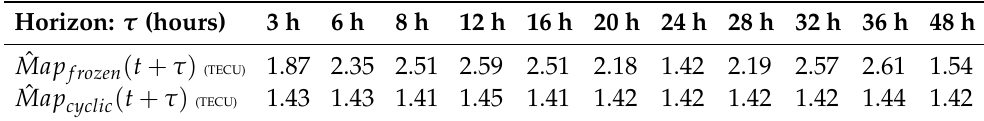
Table 4. Forecasting RMSE (TECU) for ˆ Map frozen ( t + τ ) vs. ˆ Map cyclic ( t + τ ) (June 2019). Horizon: τ